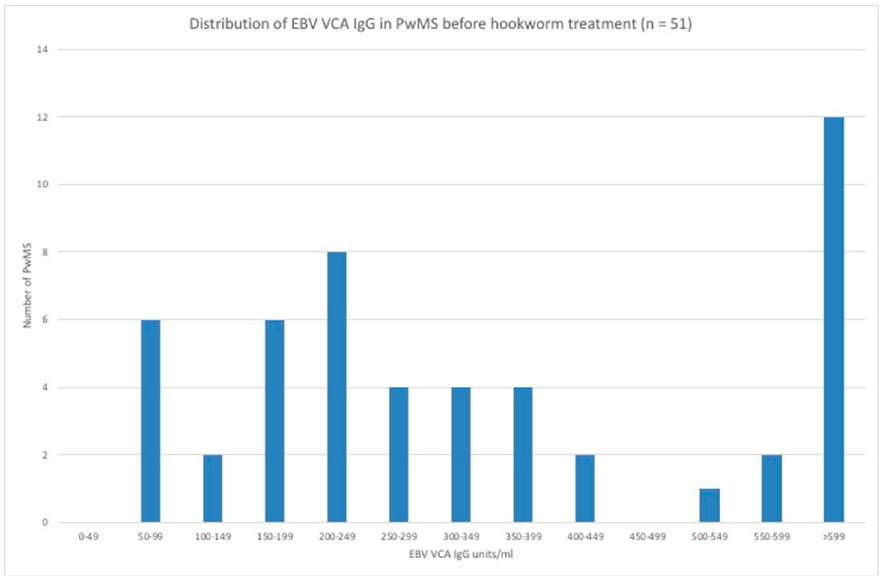
Figure 3. Distribution of EBV VCA IgG levels in PwMS at baseline.